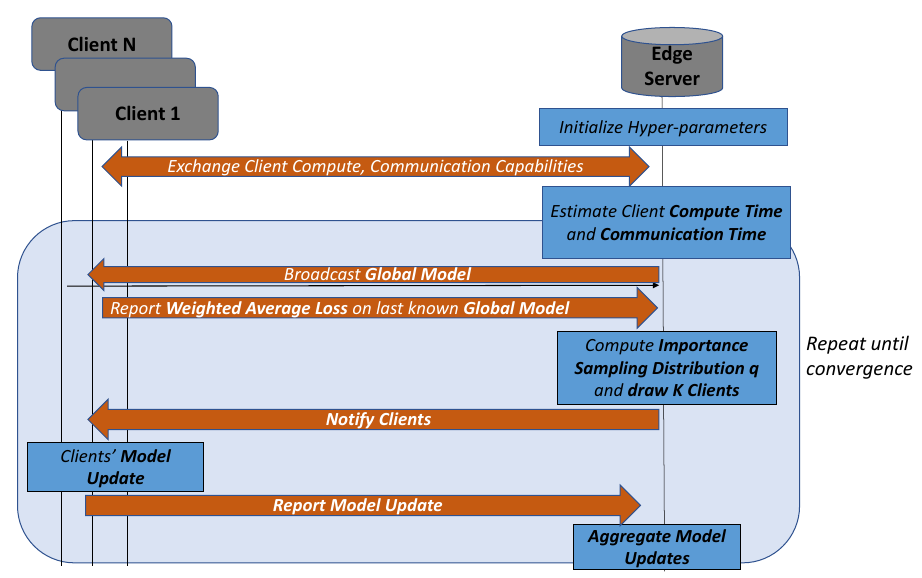
Figure 2. Federated learning (FL) with importance